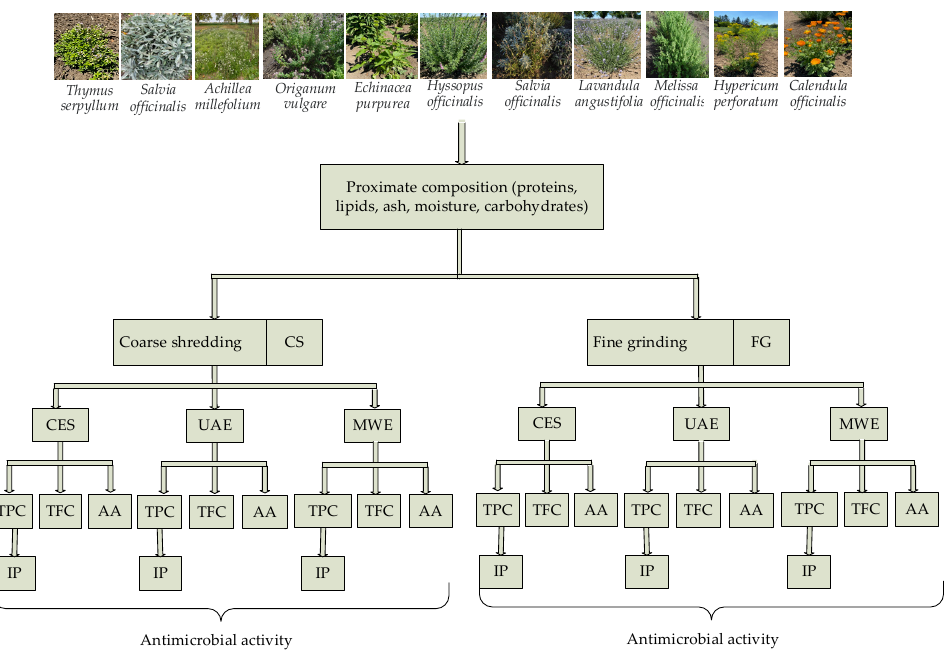
Figure 1. The flow chart of the preparation/extraction methods and analysis process.